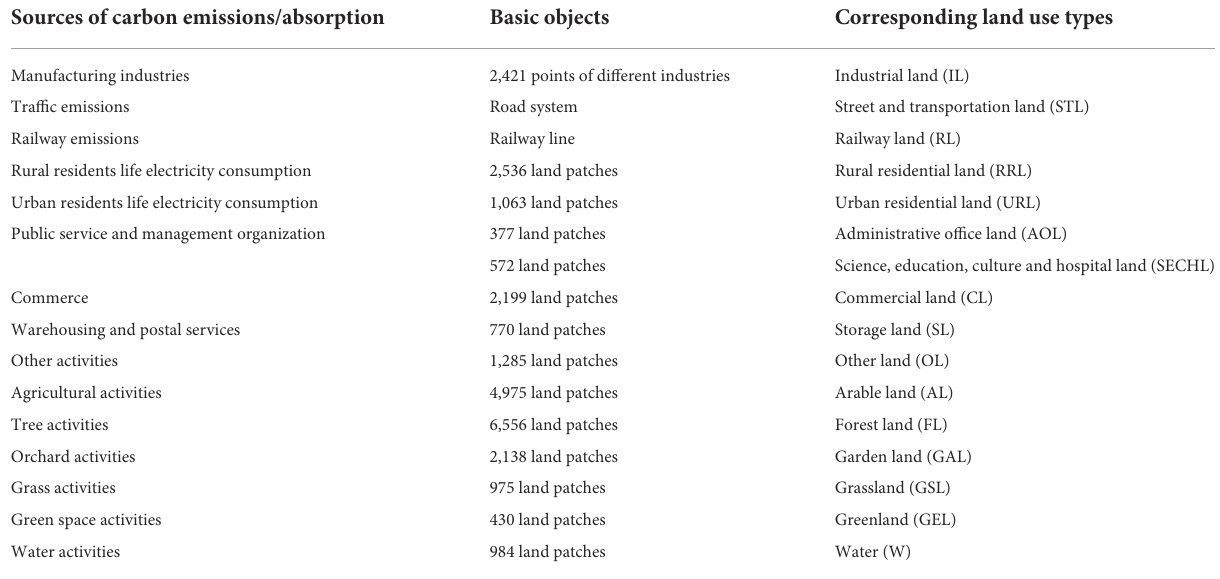
TABLE 4 The detailed allocation results of 33,232 land patches in